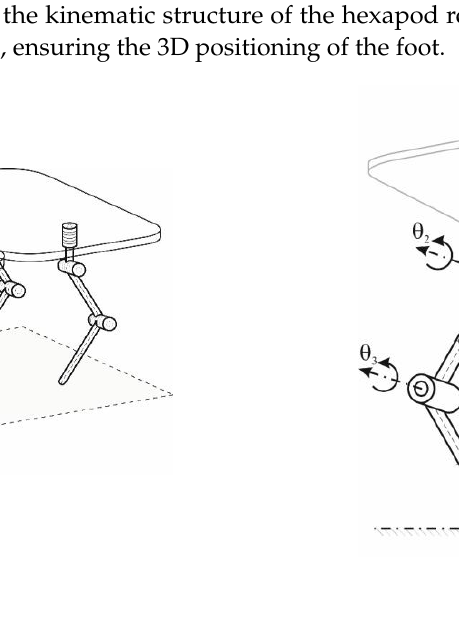
Figure 1. The robot structure: ( a ) the hexapod walking robot; ( b ) kinematic structure of the robot leg.